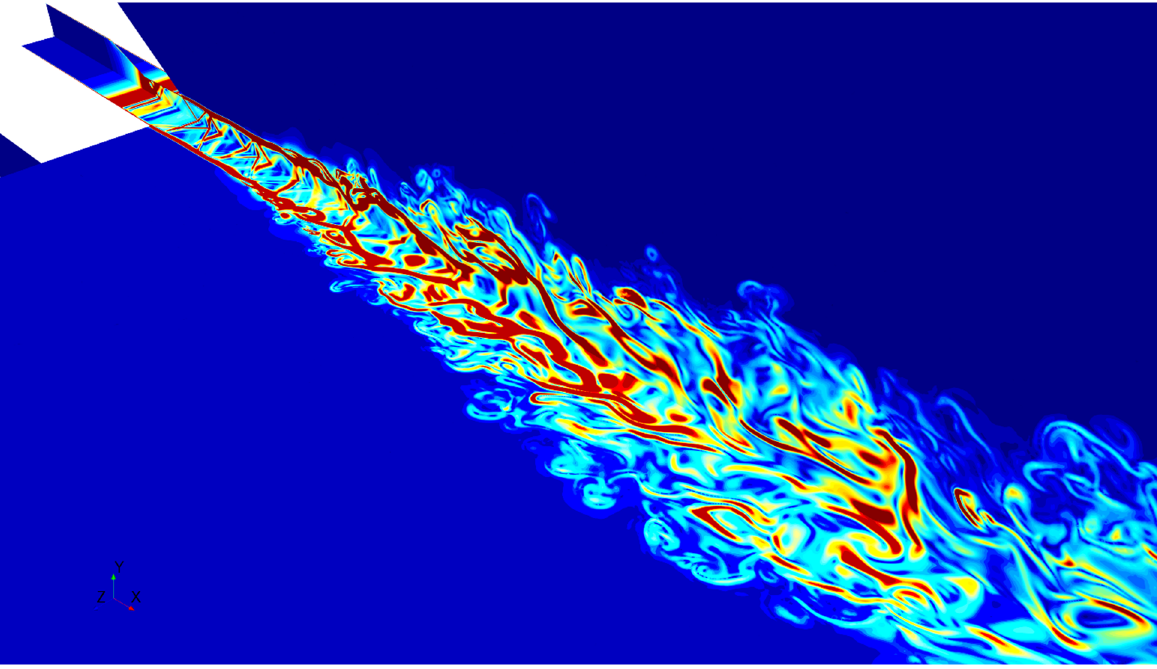
Figure 23 . LES ‐ based illustration of the jet flowfield on minor and major axis planes.